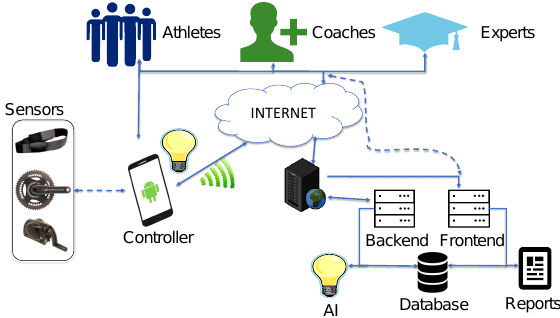
Figure 1. Architecture of Direct Mobile Coaching systems.